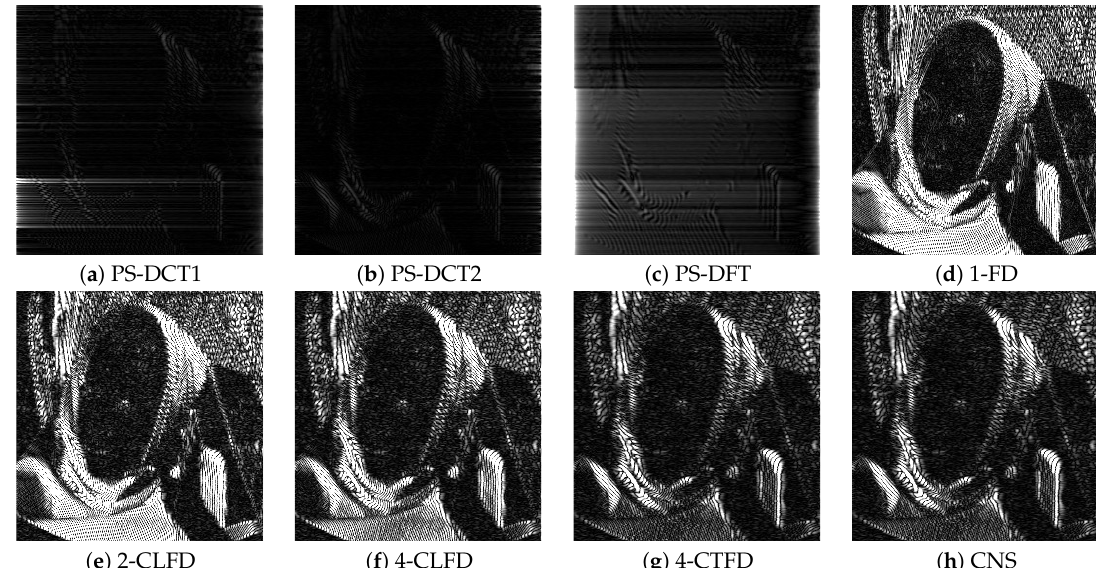
Figure 3. The absolute errors of the final output after successive image translation of the image “Barbara”. CNS, cubic natural spline.